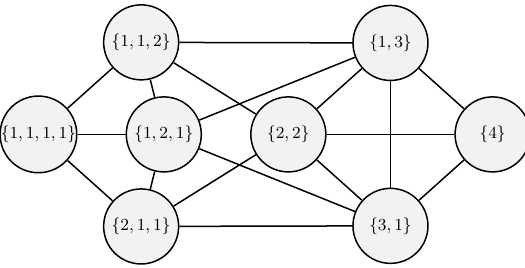
Figure 13: The network in model 2 when the total charge is Q = 4. (Unlike depicted in this simplified network figure, note that the transitions between states are not always symmetric, see